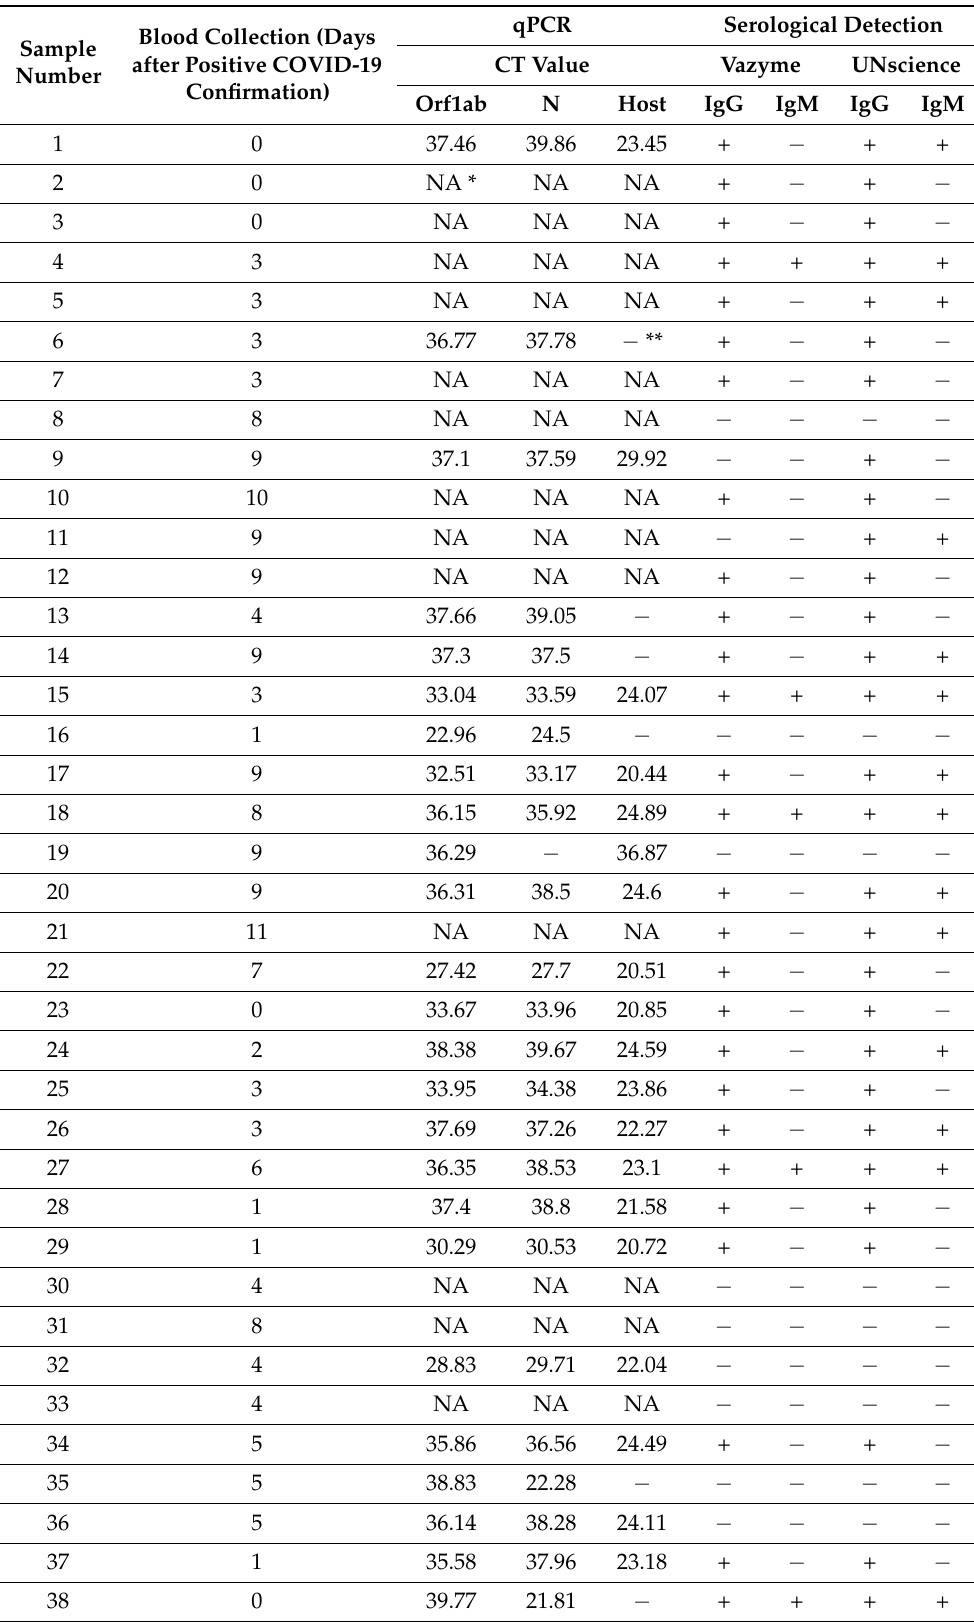
Table 3. The data of PCR test and its correlation with serological